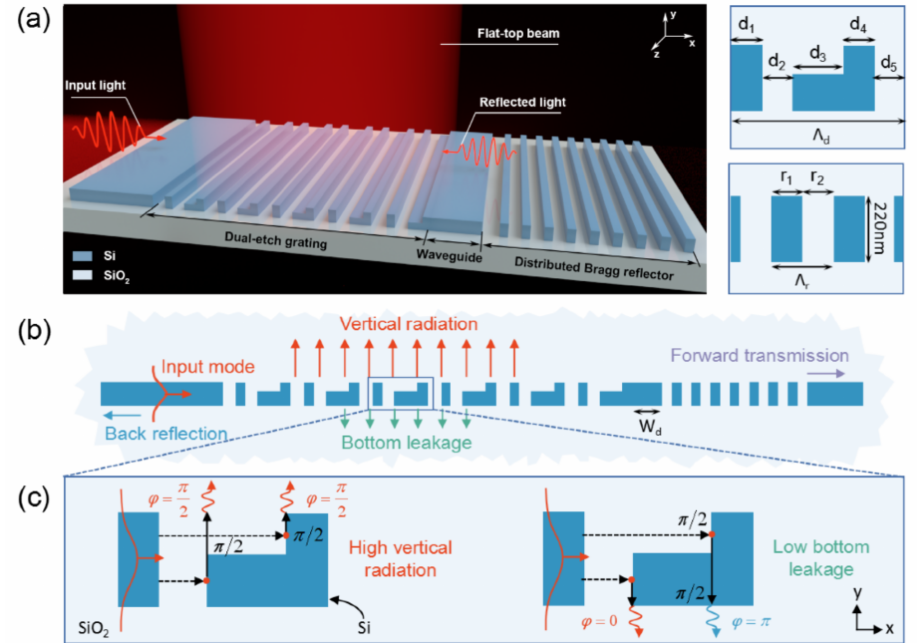
Figure 1. ( a ) Schematic of the grating coupler consisting of DG and DBR. The DG utilizes a blazed subwavelength structure with period and optimization variables [ d 1 , d 2 , d 3 , d 4 , d 5 ]. The period length of the DBR is Λ r . ( b ) Description of the operation of the grating coupler. Light is incident from the left waveguide and has four output channels, i.e., the channel along the vertical radiation, back reflection, bottom leakage and forward transmission. ( c ) Description of the operation principle of